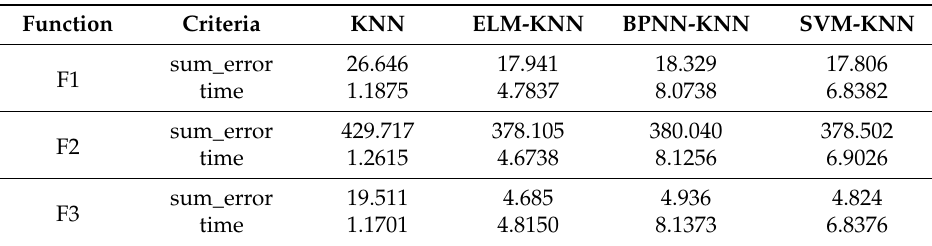
Table 2. The Fitting performance of the four